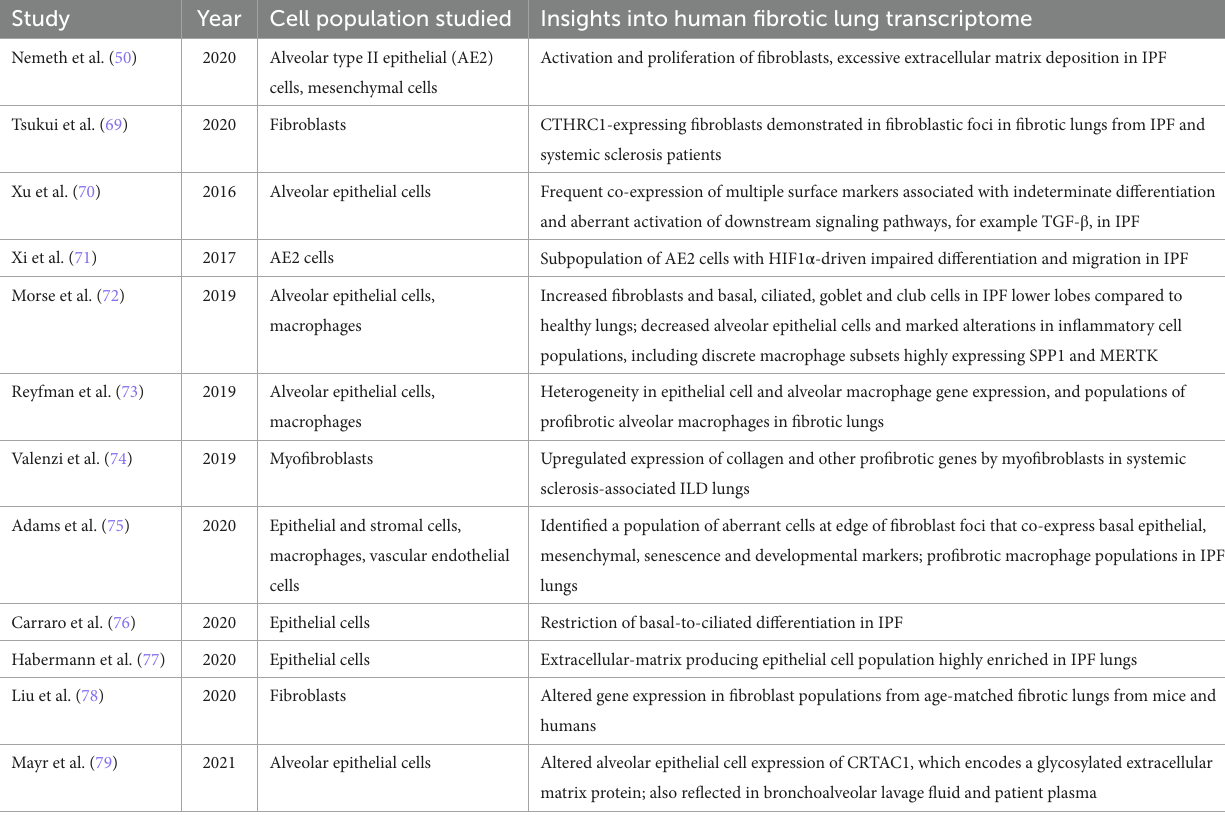
TABLE 2 Outcomes of single cell RNA sequencing studies in fibrotic ILD.